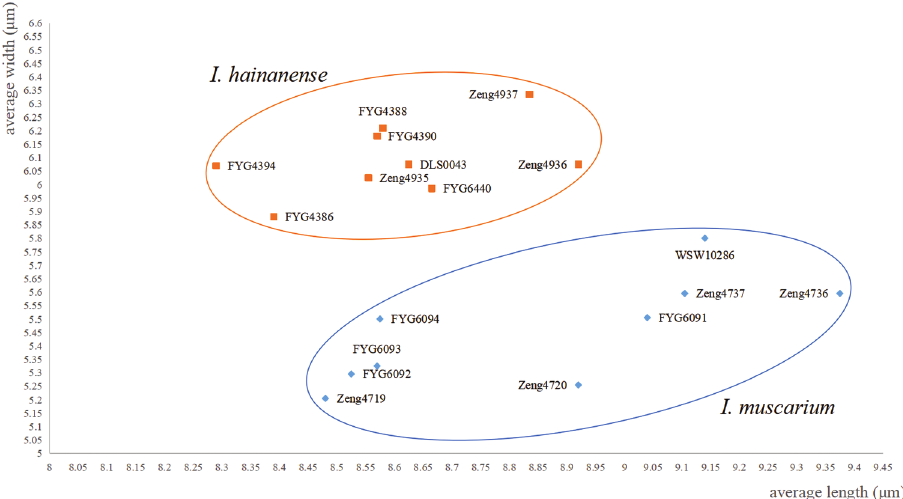
Figure 7. The comparisons of the two new species in their dimensions of